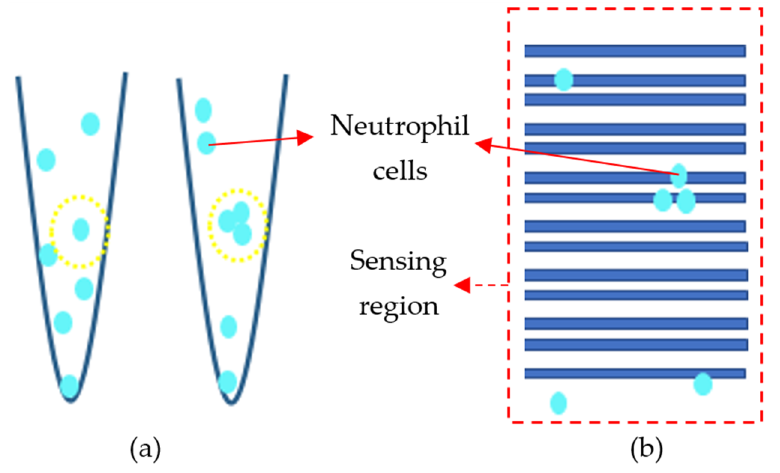
Figure 16. Nonidealities in neutrophil measurement: ( a ) non-uniformity of the cell distribution in the sample, and ( b ) non-uniformity of cells cast on the surface of the sensor.